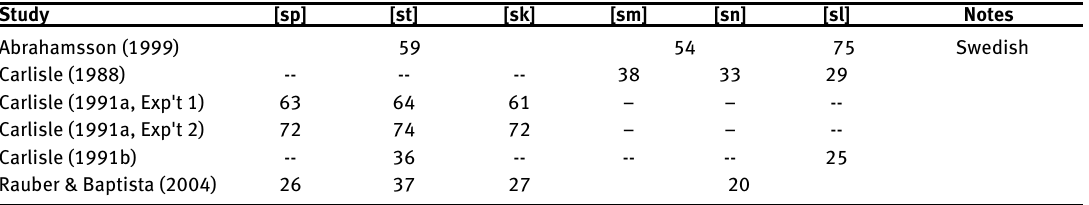
guish the clusters when reporting prothesis